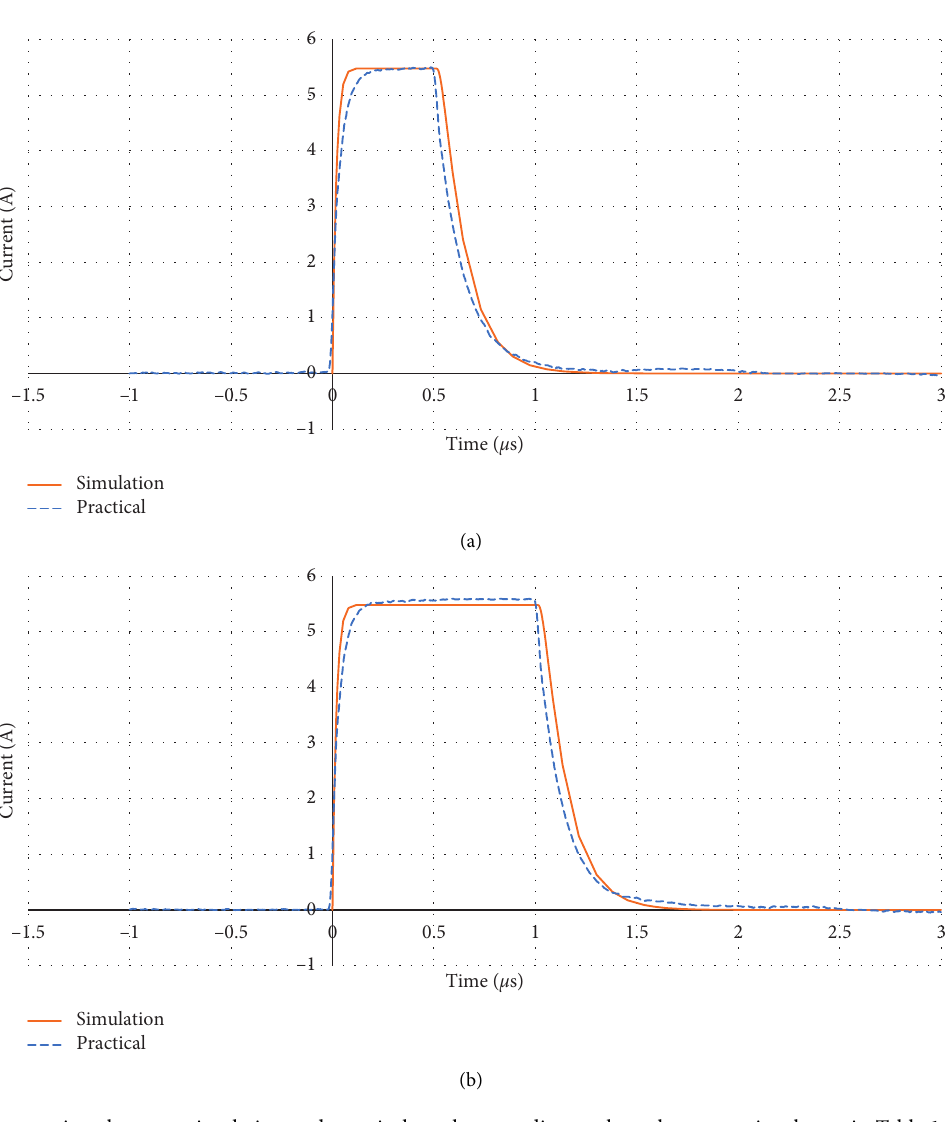
Figure 10: The comparison between simulation and practical results according to the pulse properties shown in Table 1. (a) 500ns pulse width and (b) 1000ns pulse width.